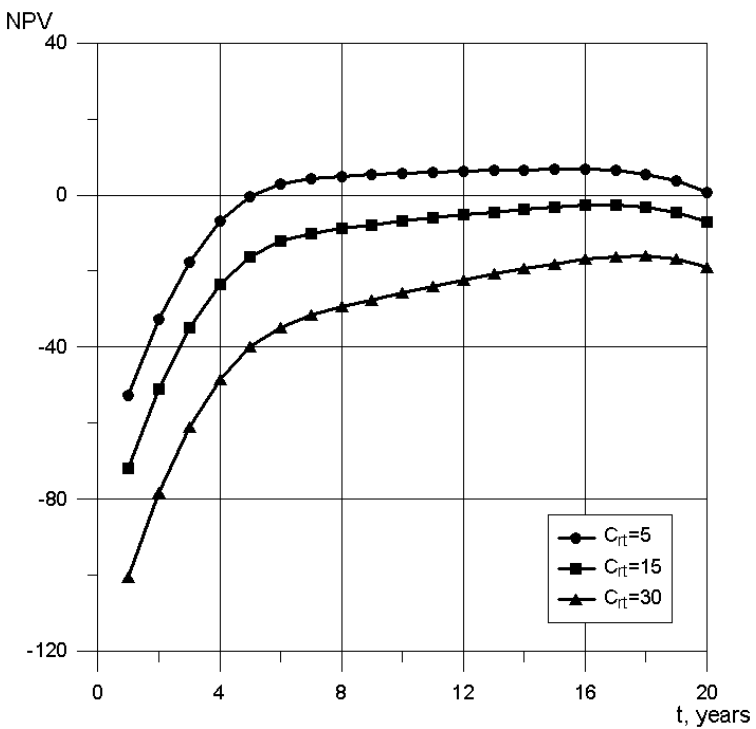
Figure 11. NPV index for 𝑎 0 = 3 mm and 𝑍 0 = 0.5 .